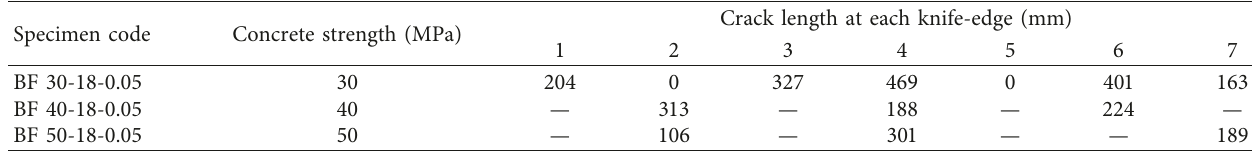
Table 10: Crack length of test specimens with different concrete strength values.